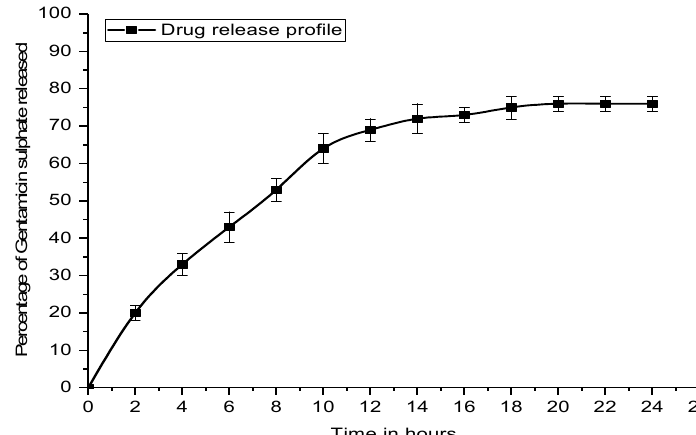
Figure 5. Drug release profile of E-G-S in phosphate-buffered saline (PBS).